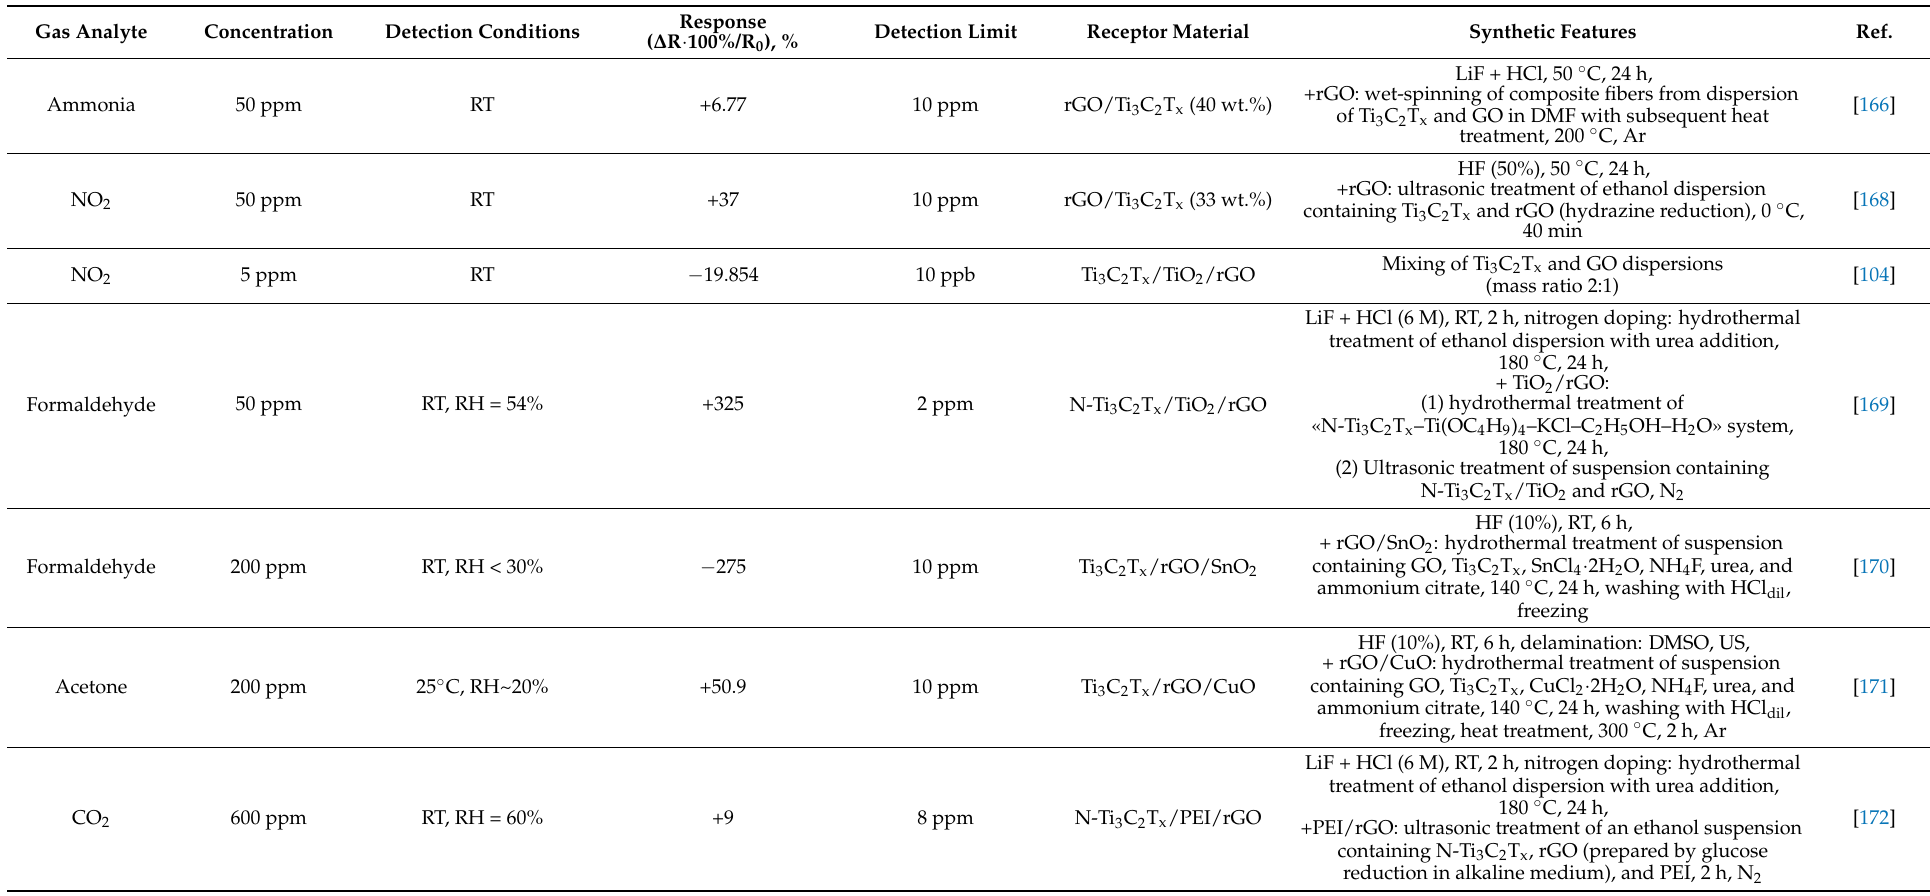
Table 4. Sensory characteristics of nanocomposite coatings containing Ti 3 C 2 T x /Ti 2 CT x MXenes and reduced graphene